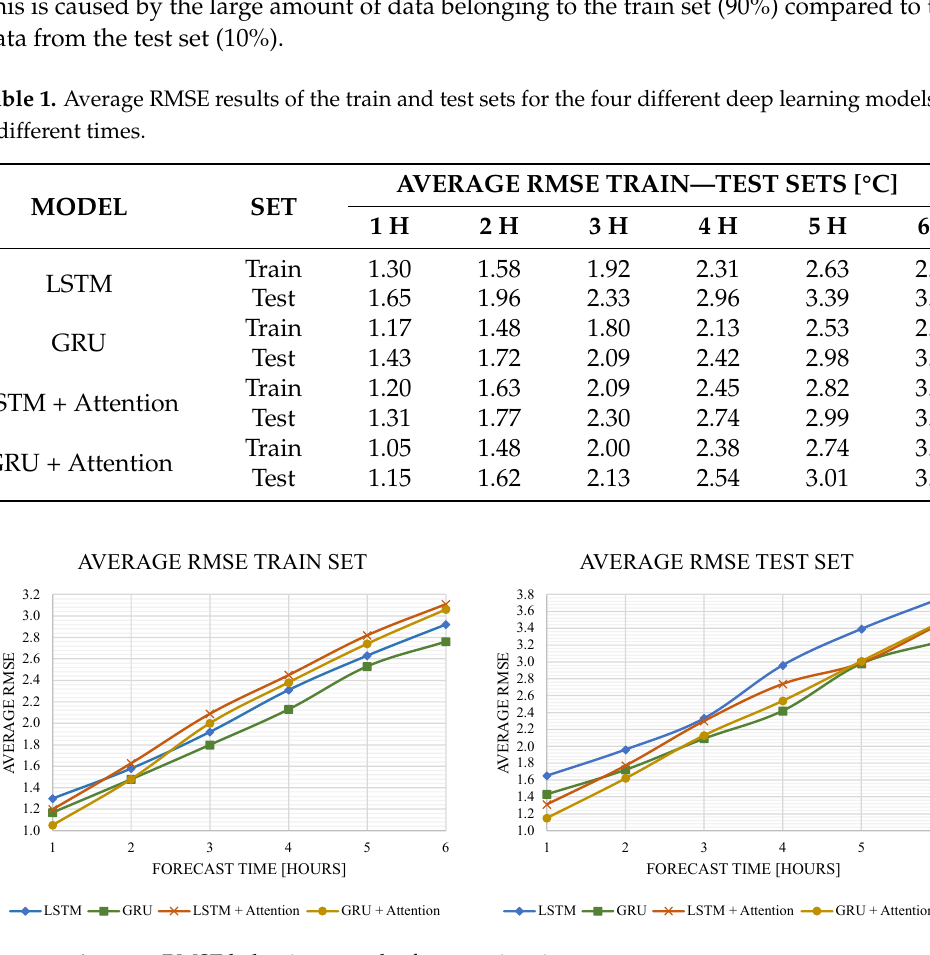
Figure 7. Average RMSE behavior over the forecast time